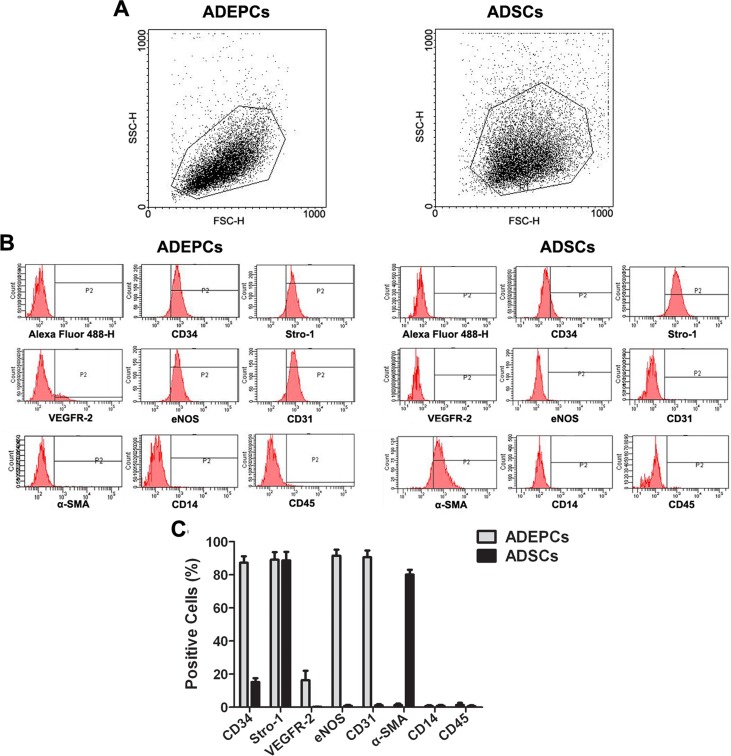
Flow cytometric analysis of ADEPCs and ADSCs.
(A) The single cell population with high forward scatter of ADEPCs and ADSCs could be obtained through our isolation technique. (B) ADEPCs were positive for CD34 (87.3±3.9%), Stro-1 (89.1±4.6%), VEGFR-2 (16.3±5.7%), eNOS (91.5±3.7%) and CD31 (90.6±4.1%) but negative for α-SMA, CD14 and CD45. ADSCs were positive for CD34 (15.2±2.3%), Stro-1 (88.7±5.2%) and α-SMA (80.1±2.9%), but negative for VEGFR-2, eNOS, CD31, CD14 and CD45. (C) Quantification of surface markers (means expressed as percentages; n = 6).